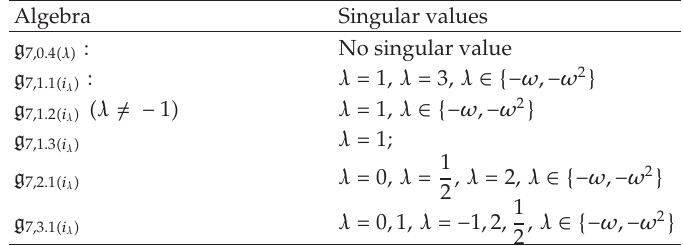
Table 1: Singular values for continuous series of 7-dimensional